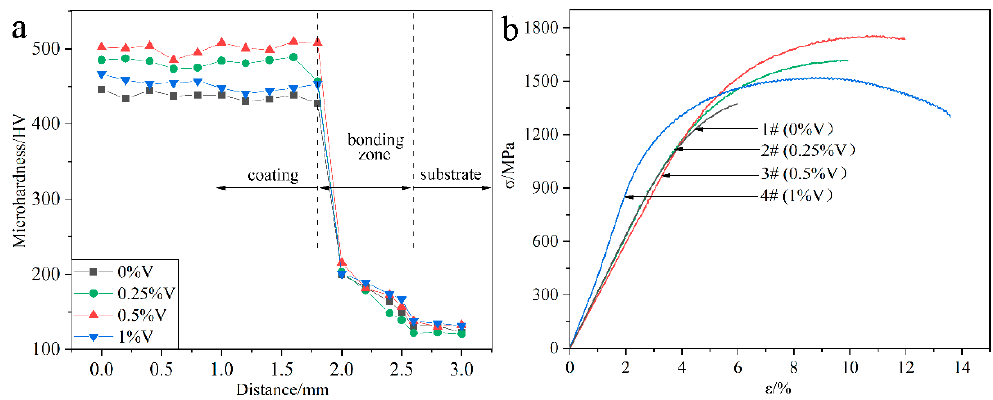
Figure 7. Mechanical properties of the laser-cladded coatings with different V contents: ( a ) microhardness distribution; and ( b ) tensile curves. Table 2. Comparison of tensile mechanical properties of different laser-cladded MSS coatings